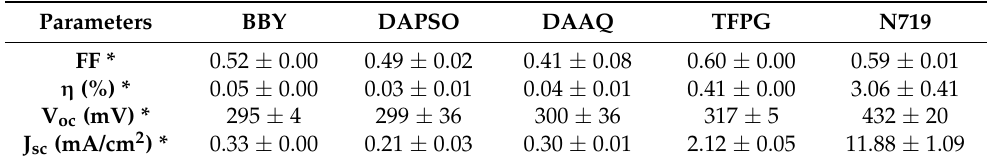
Table 1. Photovoltaic performance parameters of DSSCs based on the use of COF starting materials as dyes after adsorption for 5 h, under simulated AM 1.5 G illumination at 100 mW/cm 2 . ( The presented results correspond to the best-performing cell ). Parameters BBY DAPSO